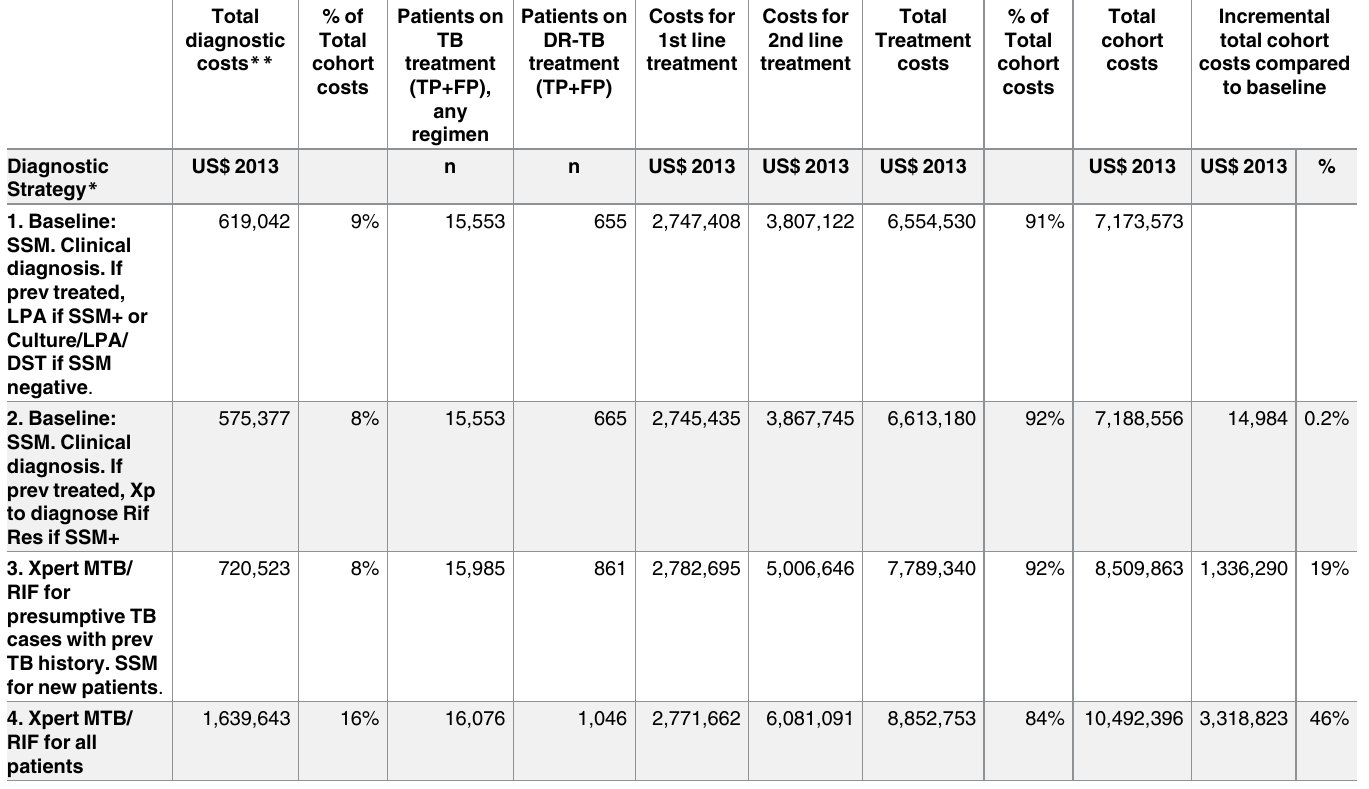
Table 3. Total diagnostic costs and treatment costs to test 100,000patients, for 4 diagnostic strategies (Cost in